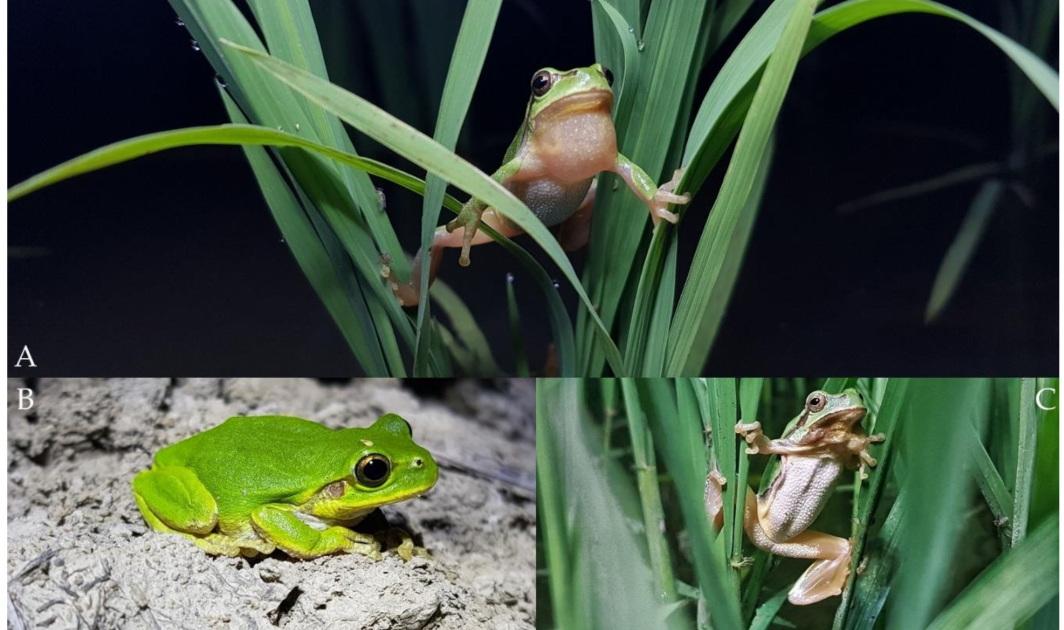
Figure 2. Pictures of the focal species in situ. ( A ) Dryophytes suweonensis (Suweon treefrog) in Asan, R Korea, June 2020; ( B ) Dryophytes flaviventris (Yellow–bellied treefrog) in Iksan, R Korea, May 2019; ( C ) Dryophytes immaculatus (Chinese immaculate treefrog) near Nanjing, PR China, June 2019. Males in ( A , C ) are holding onto rice seedlings while calling, the typical calling behavior of all three species. All pictures taken by